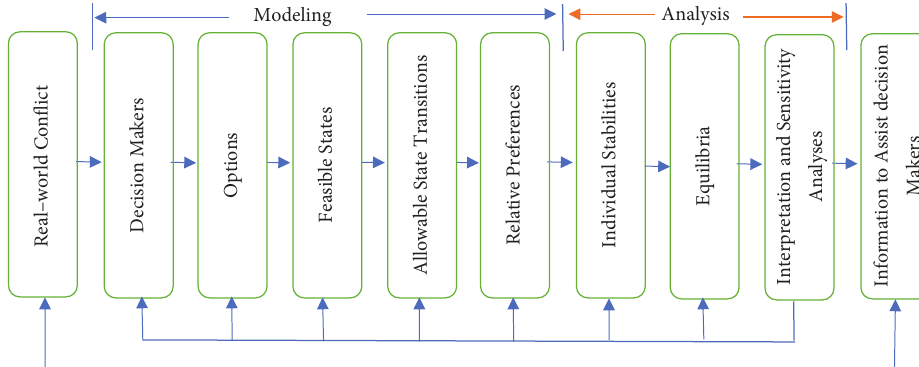
Figure 1: Conflict resolution process in GMCR adapted from